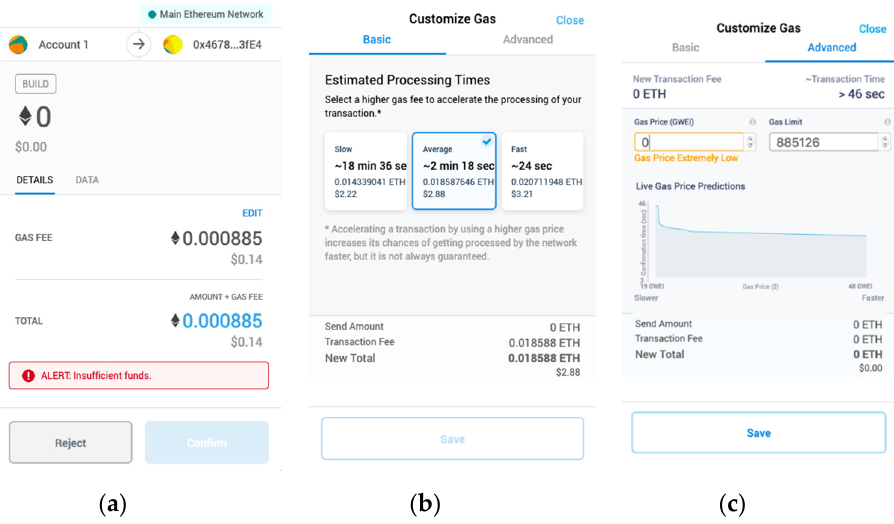
Figure 3. Sending a transaction to an Ethereum Smart Contract ( a ) and deciding how much gas to spend ( b ) and customizing it for a private Blockchain ( c ).